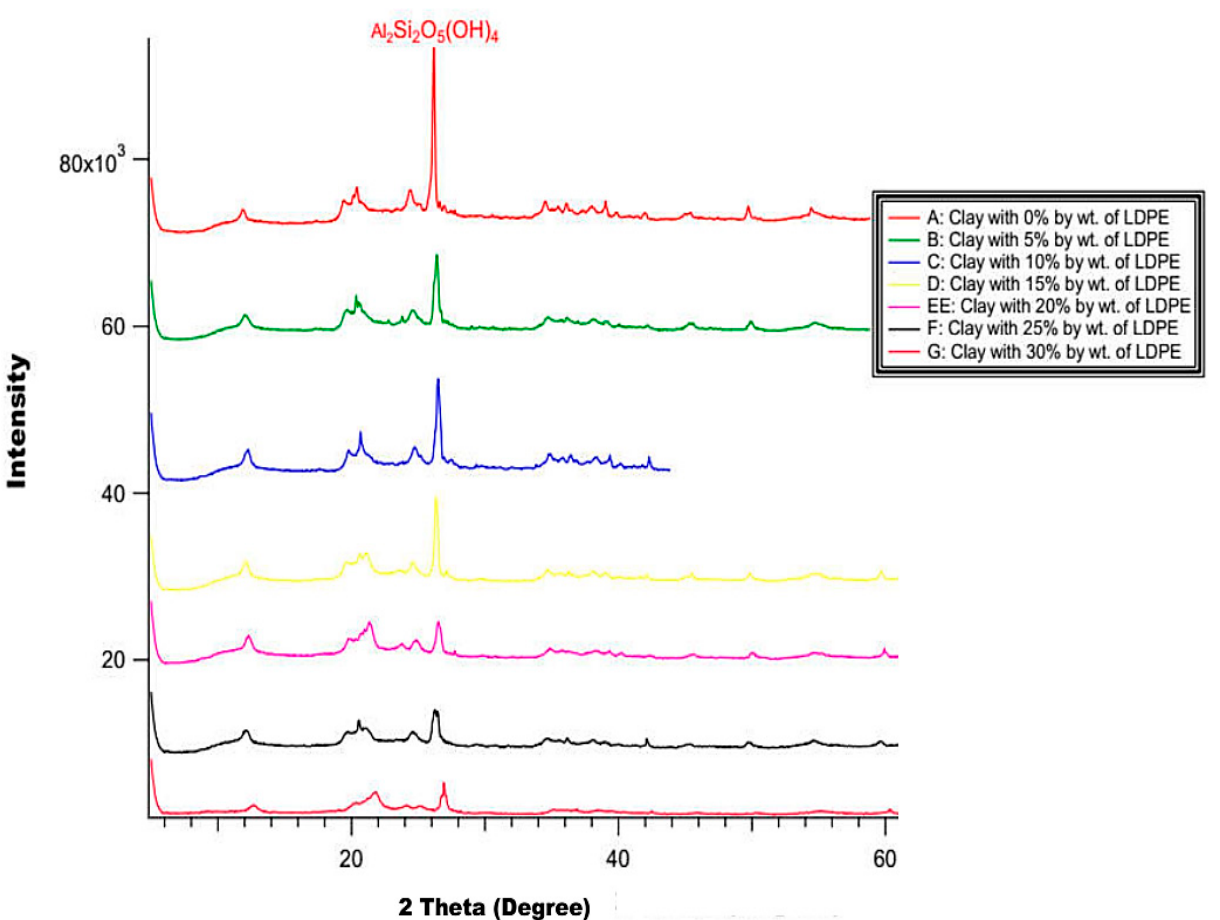
Figure 3. X-ray Diffraction (XRD) patterns of the studied Samples.